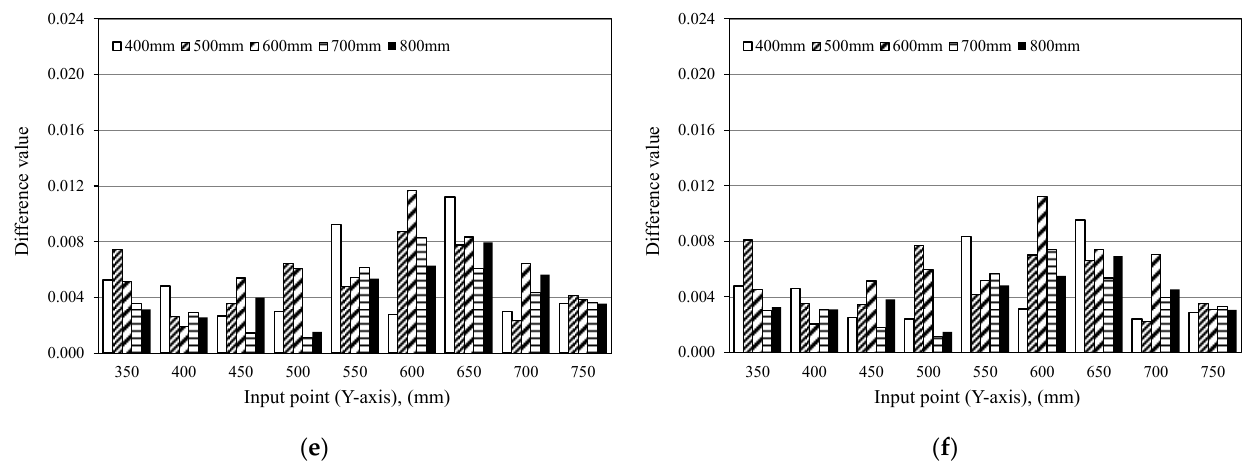
Figure 15. DVA results for Case_3 ( φ S : 33 mm, Depth: 50 mm): ( a ) N = 100; ( b ) N = 250; ( c ) N = 500; ( d ) N = 1000; ( e ) N = 1500; ( f ) N = 2000. Table 6. Propagation time and distance.